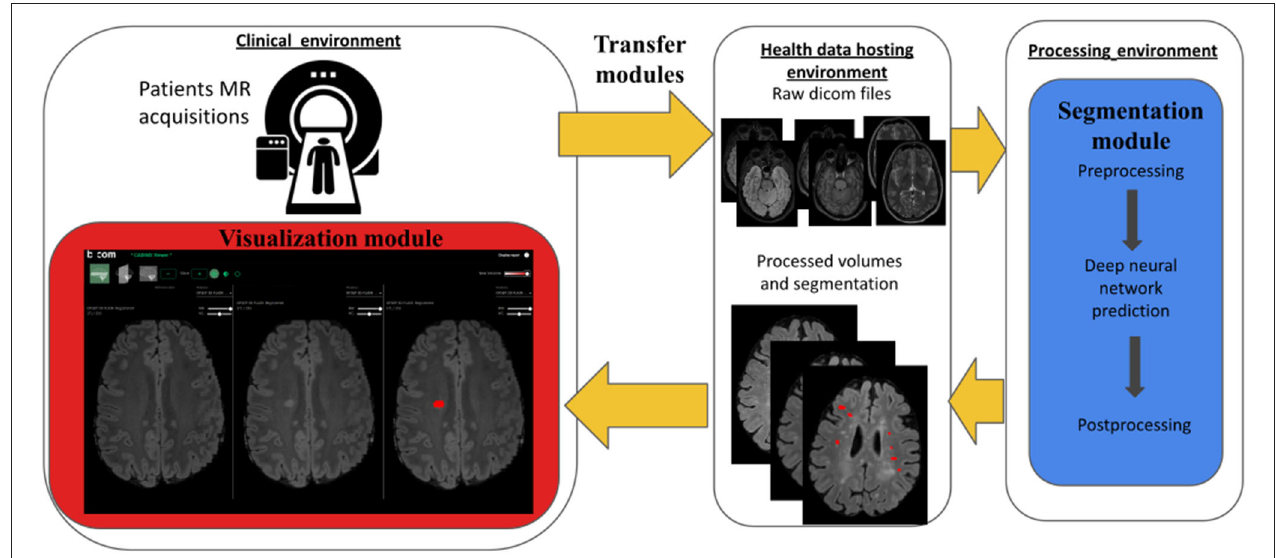
FIGURE 1 | Workflow overview. Colored elements were specifically designed and developed in the context of our MUSIC project and consists of (i) a set of Transfer and Storage Modules (yellow), (ii) a Segmentation Module (blue) and (iii) a Visualization Module (red). Briefly, after being stored in the clinical PACS, MR images are pseudonymised and securely transferred into a processing hosting, where images are processed so that new lesions are automatically segmented. Then the resulting processed images and associated new lesions segmentation maps are returned to the clinical data hosting platform where they can be visualized in a dedicated web MRI